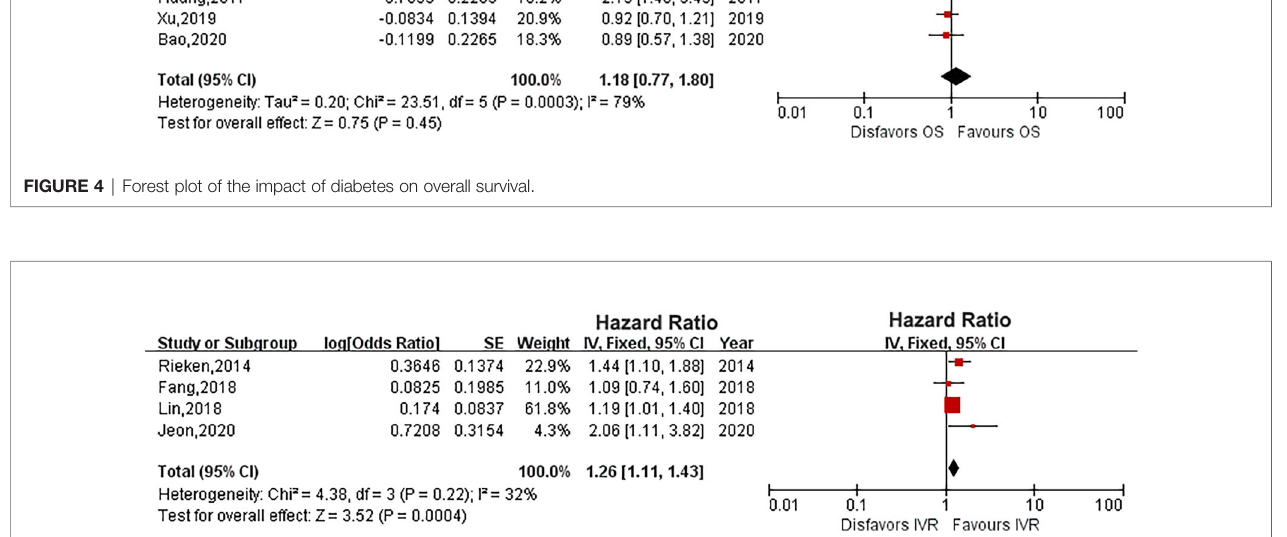
FIGURE 5 | Forest plot of the impact of diabetes on intravesical